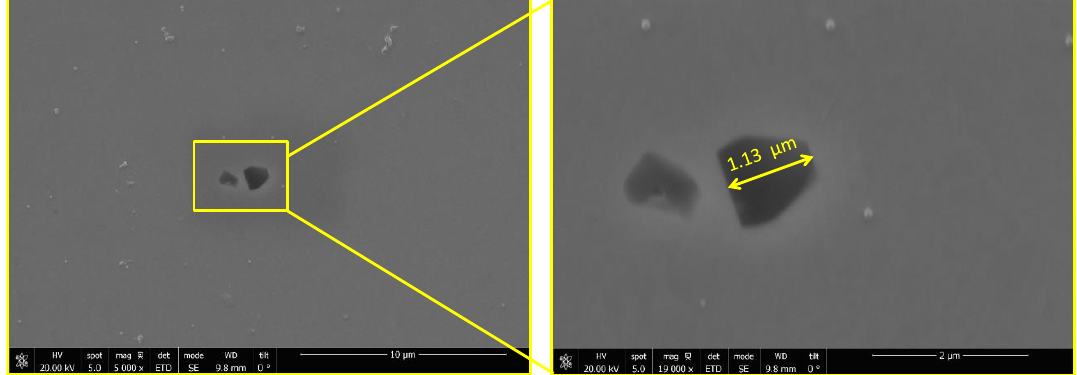
Figure A11. ( a ) Montage of SEM images showing fracture surface of locking screw (LC), ( b – d ) pore or site of inclusion pull out after fracture resulting in dimples and/or porosity.